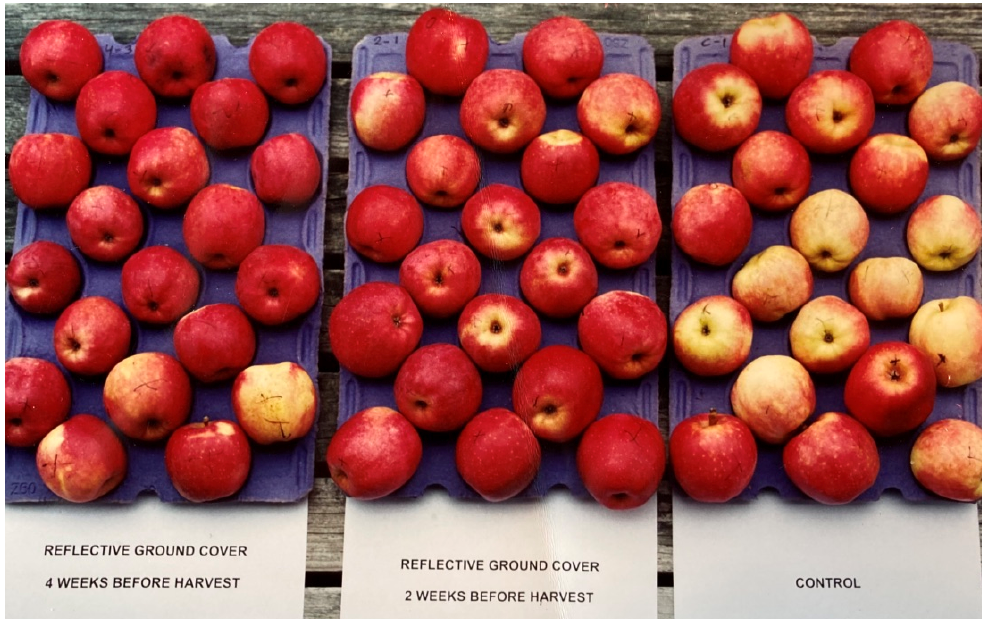
Figure 13. Effect of reflective mulch on fruit colouration of cv. Pacific Rose at harvest- most conspicuous on the (down-facing) apex side of the apple fruit.